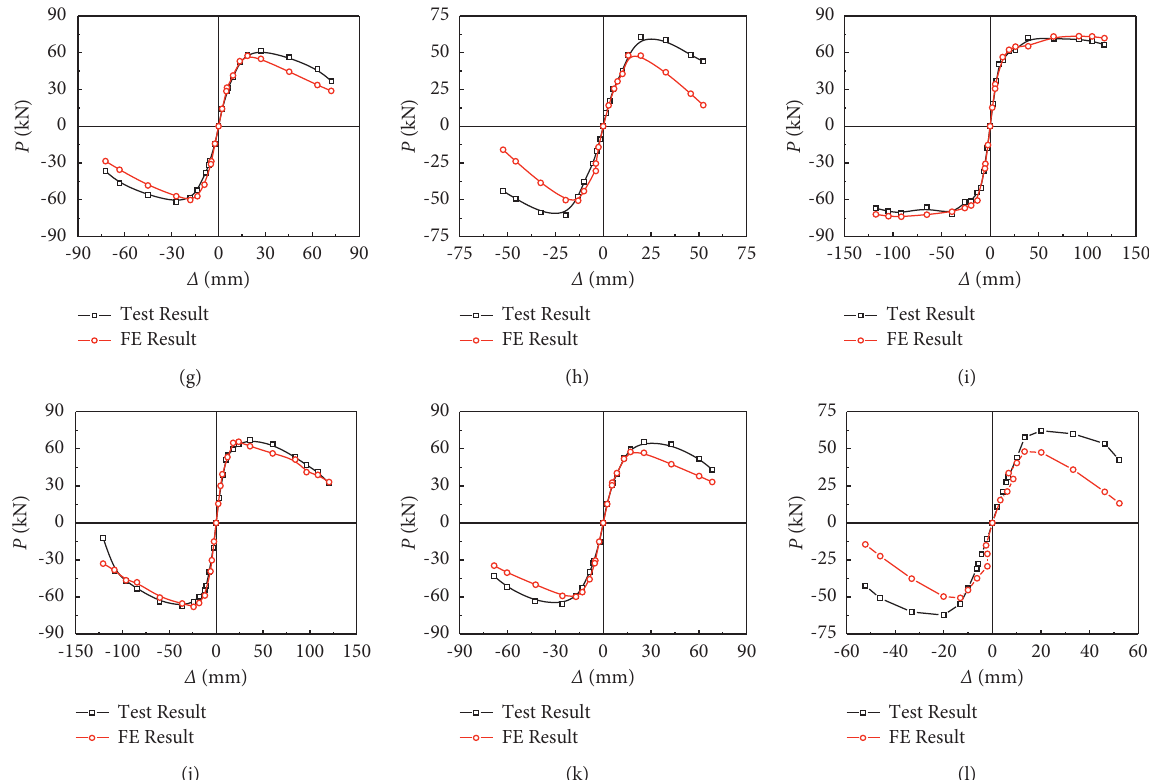
Figure 14: Comparison of simulation results and experimental results of P - Δ skeleton curves of specimens. (a) A0 specimen. (b) B0 specimen. (c) C0 specimen. (d) D0 specimen. (e) A1 specimen. (f) B1 specimen. (g) C1 specimen. (h) D1 specimen. (i) A2 specimen. (j) B2 specimen. (k) C2 specimen. (l) D2 specimen.